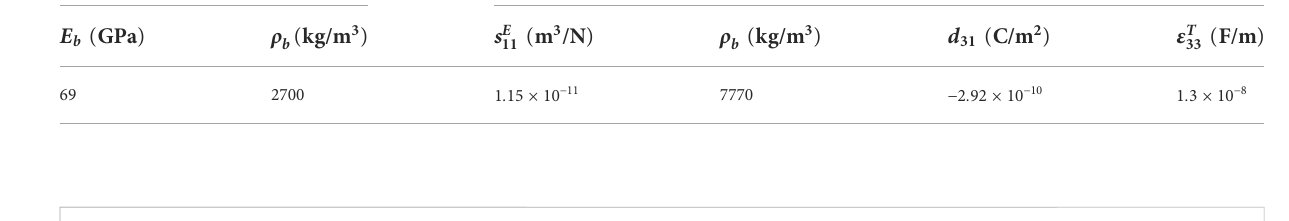
(cid:2) R (cid:2) 0, (B) case 2: R 1 2